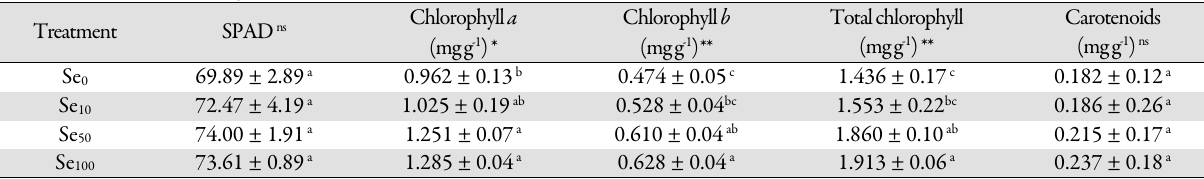
Table 3. Photosynthetic pigments of broccoli as affected by Se treatments Treatment